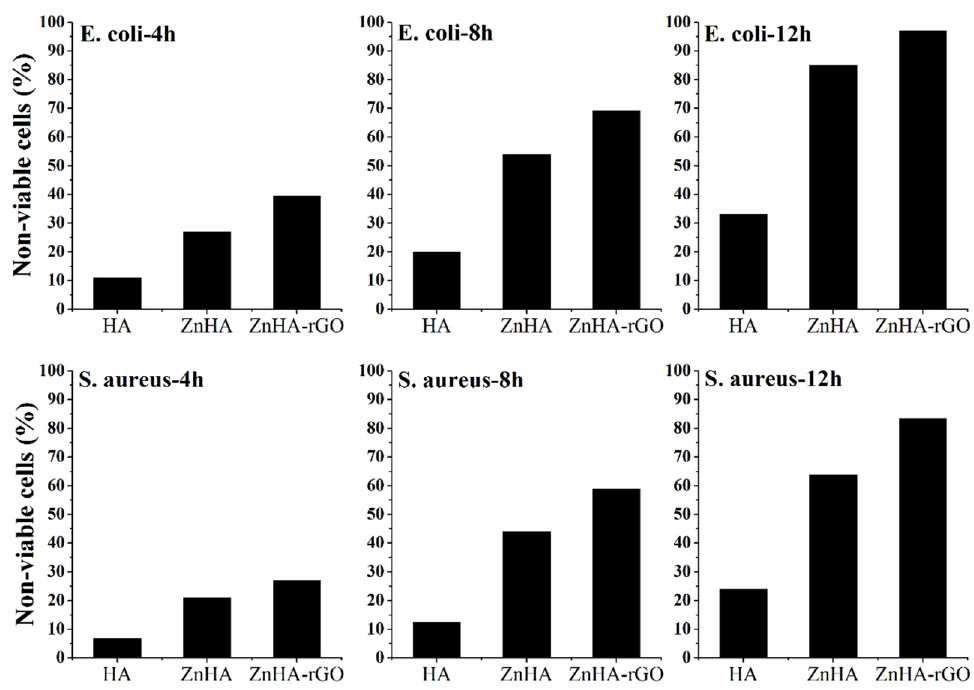
Figure 6. The loss of viability of E. coli and S. aureus bacteria after incubation with 100 µg mL − 1 concentration of HA, ZnHA, and ZnHA-rGO nanoparticles for different time exposure (4, 8, and 12 h).